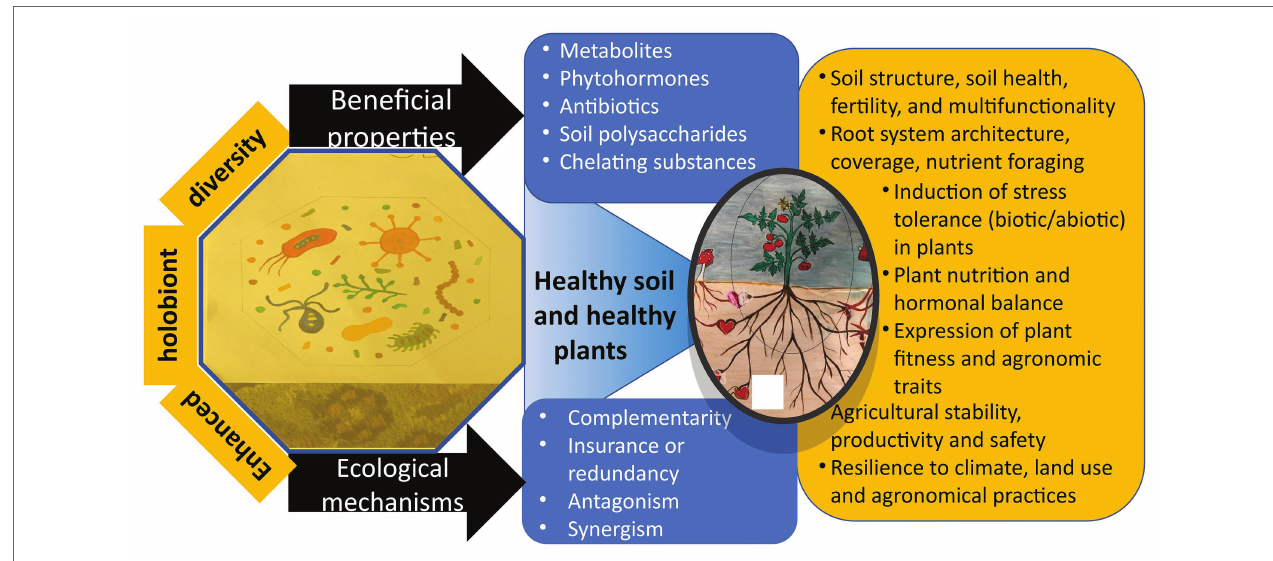
FIGURE 4 | Summary of the various components and management systems that interact to provide optimal performance of plant